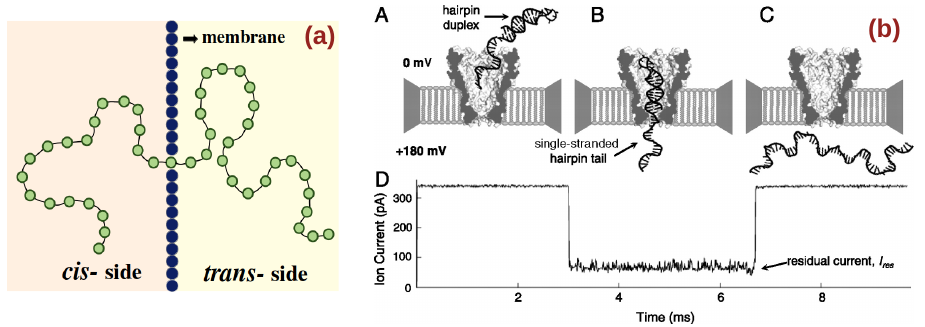
Figure 1. ( a ) Schematics of the configuration of a translocating polymer through nanopore in a membrane. ( b ) A cartoon representation of various stages of DNA translocation through an